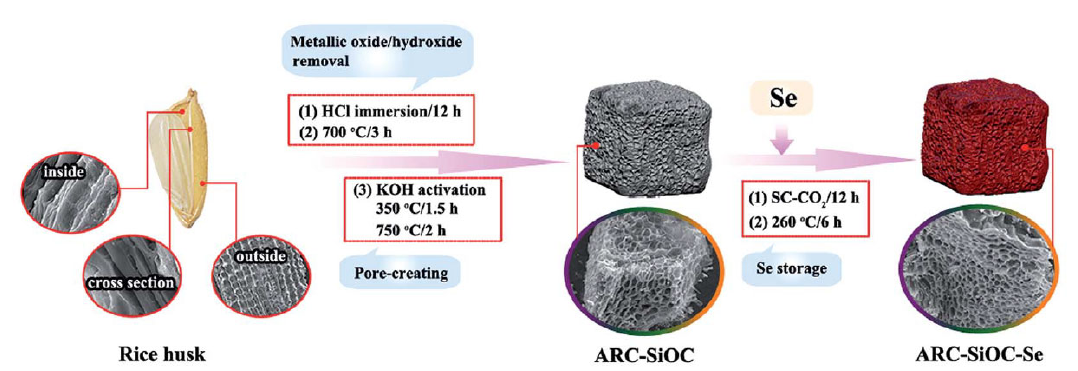
Fig. 24 Schematic diagram of carbon-rich SiCN/S cathode preparation. Reproduced with permission from Ref. [490], © Elsevier Ltd. 2021.